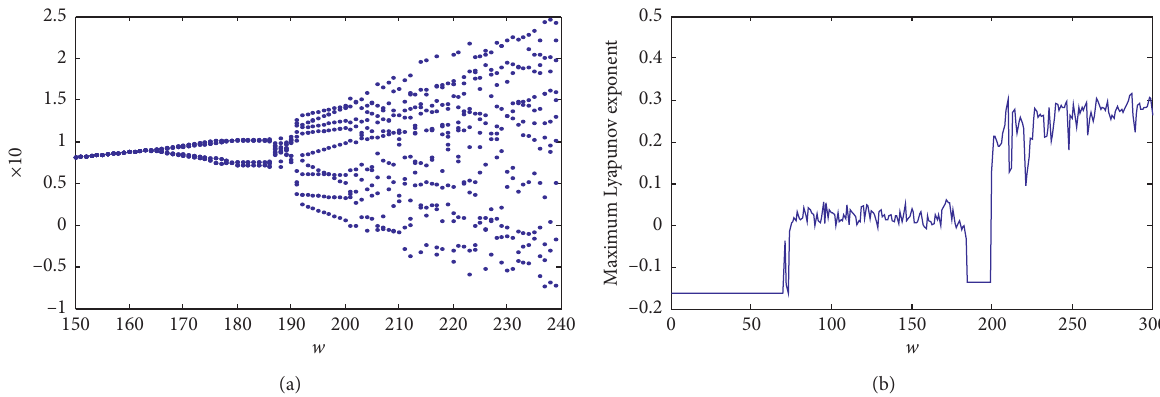
Figure 13: (a) Vibrational bifurcation diagram with k